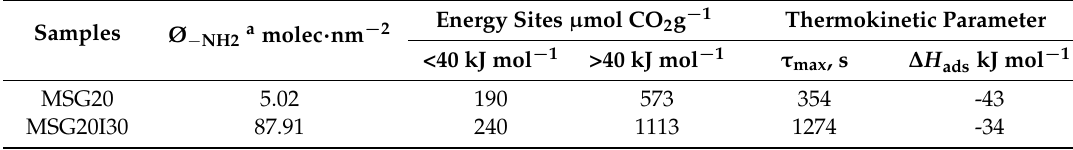
Table 3. Amine density related to calorimetry characterization